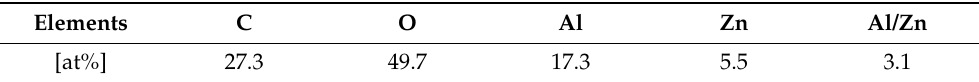
Figure 3. Survey spectrum for bare hot-dip galvanized steel after solvent cleaning obtained by XPS. The atomic concentration of the different elements is presented in Table 3. The atomic concentration of carbon was low for an industrial surface (around 30%) showing that the solvent cleaning step was successful in degreasing the surface [1]. Oxygen was the most abundant element on the surface showing the oxidized state of the native film. Table 3. Atomic concentration obtained by XPS of the different elements constituting the surface of bare HDG steel after solvent